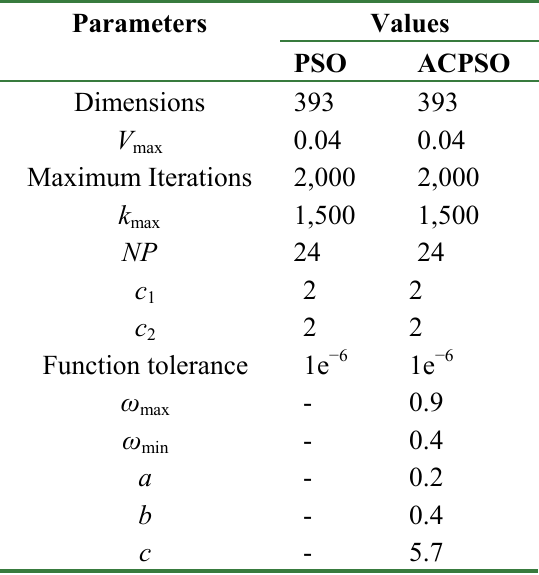
Table 7. Parameters of PSO &